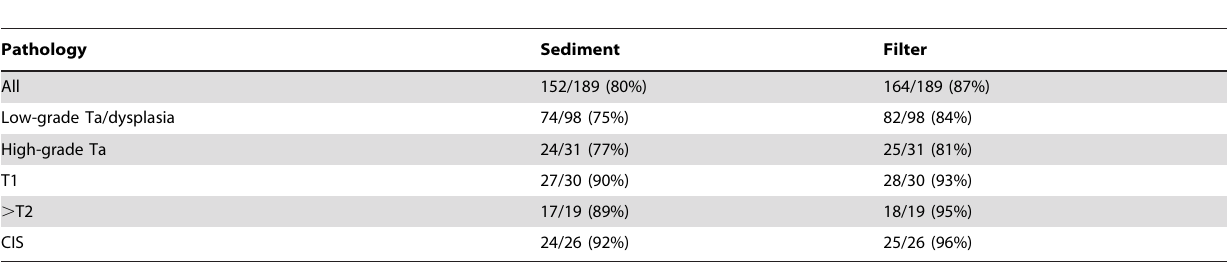
Table 1. Sensitivity of seven DNA methylation markers in filter and sediment samples from bladder cancer patients (N =189).